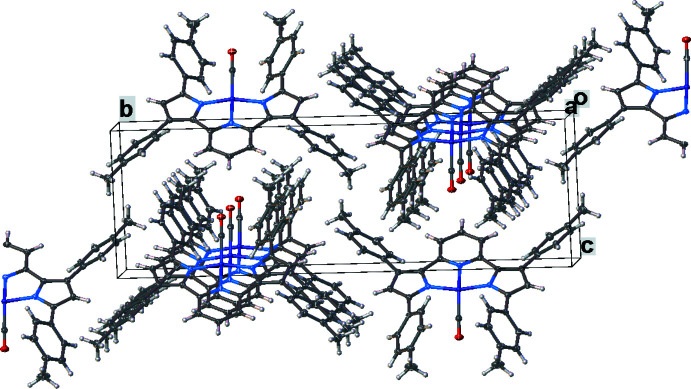
The crystal packing of [pyrr2Py]Ni(CO).